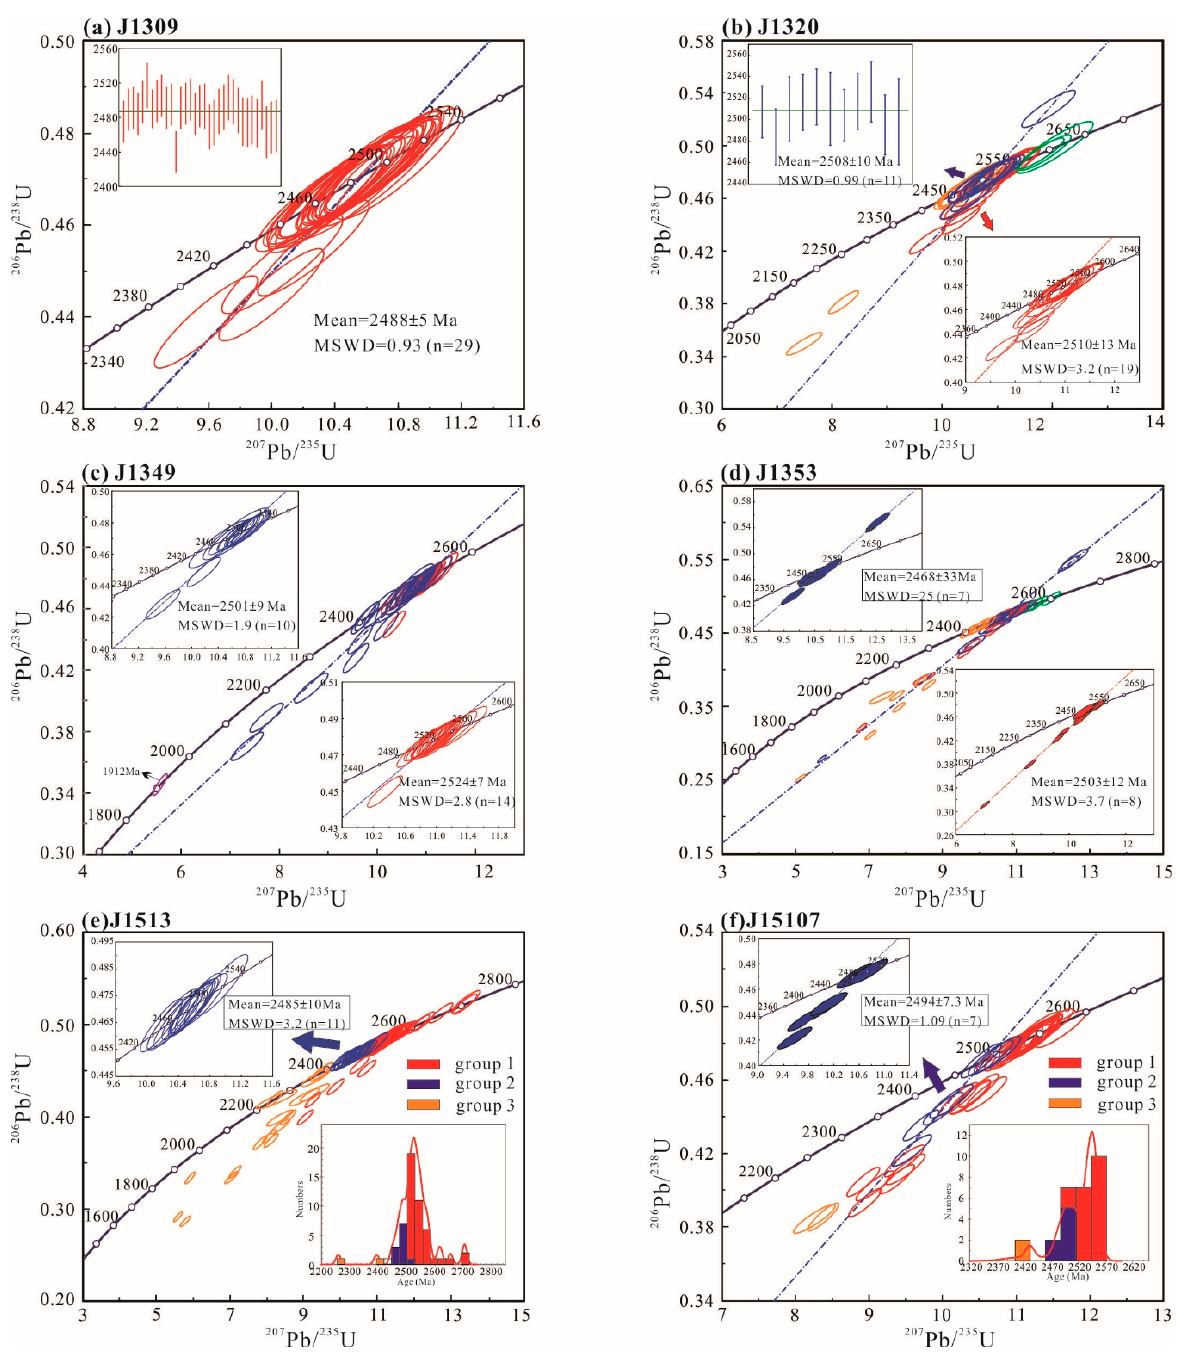
Figure 6. Concordia diagrams and histograms of apparent 207 Pb /206 Pb ages of LA–ICP–MS U–Pb data for zircons from representative samples, Eastern Hebei. ( a ) J1309 syenogranite; ( b – d ) J1320, J1349, J1353 orthogneisses; ( e , f ) J1513, J15107 felsic paragneisses.